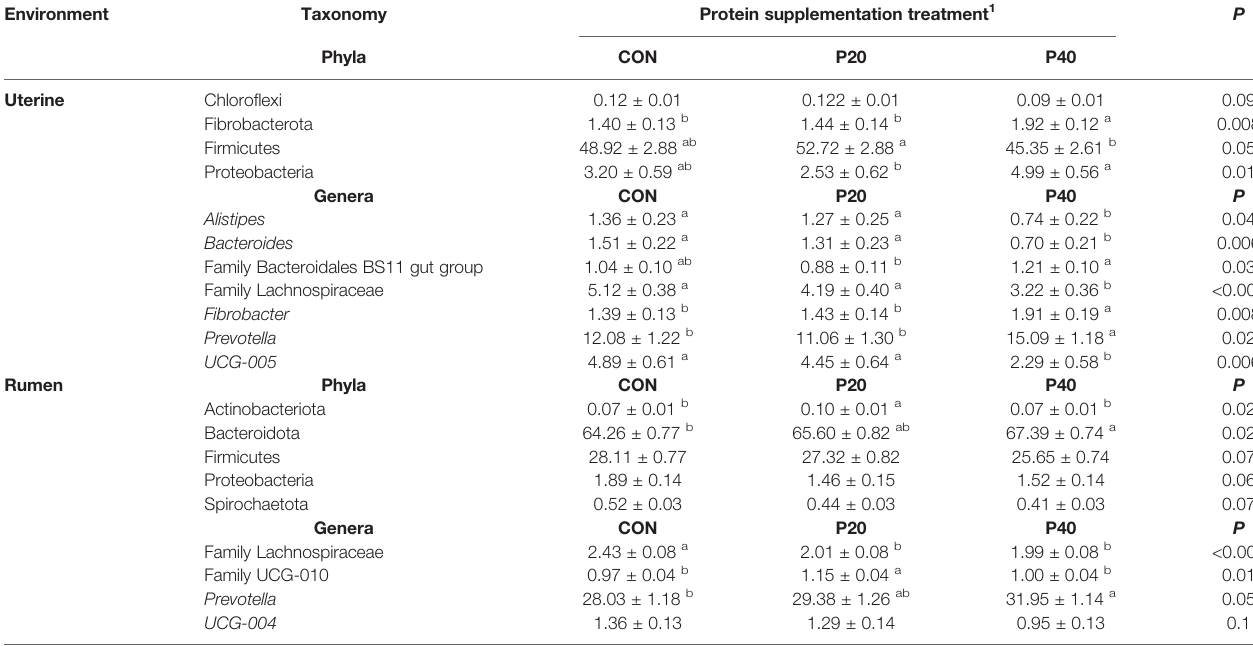
TABLE 2 | Bacterial phyla and genera with relative abundance ≥ 1% in the uterus and rumen impacted by protein supplementation treatment. Environment